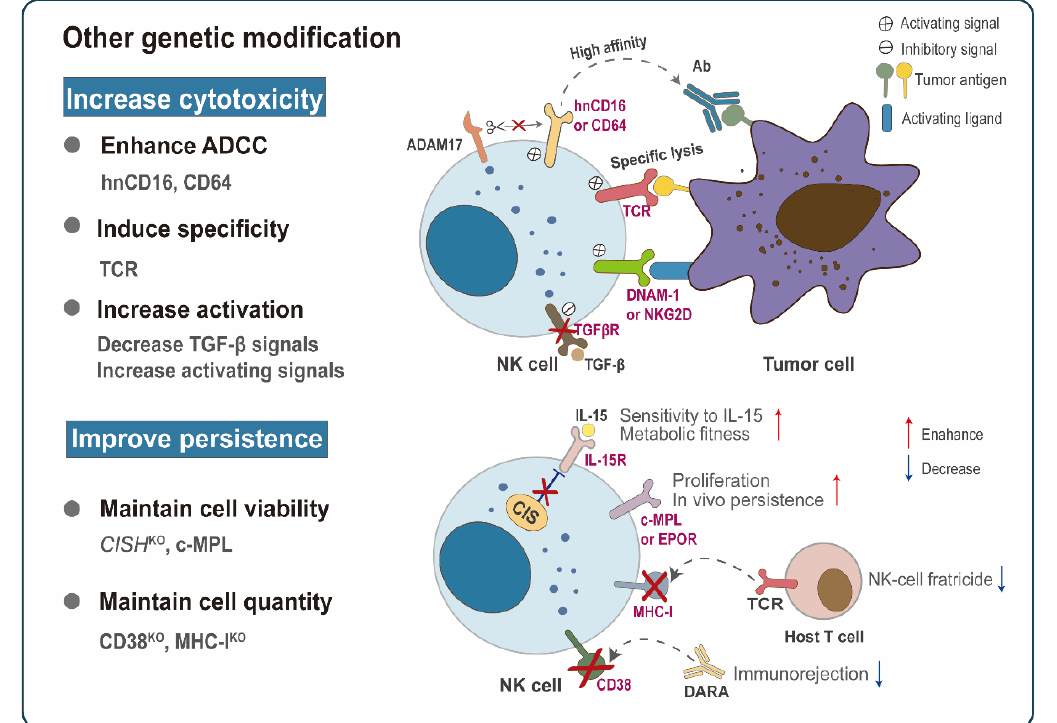
Figure 4. Other advanced genetic modification strategies. Other non-CAR structure-based genetic modifications have also been explored to improve NK cytotoxicity and in vivo persistence. For example, the introduction of high-affinity non-ADAM17 cleavable CD16 (hnCD16) or CD64 signifi- cantly enhances the affinity of NK cells to the tumor-targeting antibodies (Abs), thereby improving antibody-dependent cell-mediated cytotoxicity (ADCC). TCR NK cells achieve similar tumor control as redirected T-cells while retaining their NK cell function. Targeting TGF- β signaling or transducing activating receptors (DNAM-1, NKG2D) can tilt NK cells toward activation. Strategies to improve in vivo persistence mainly focus on maintaining the viability and quantity of NK cells. Under low cytokine concentration, possible methods to maintain cell vitality include the deletion of CISH or the expression of c-MPL or EPOR. Prolonged persistence can also be achieved by deleting the endoge- nous CD38 or MHC-I of NK cells so that the infused NK cells are undetectable to the daratumumab (DARA) or the recipient’s